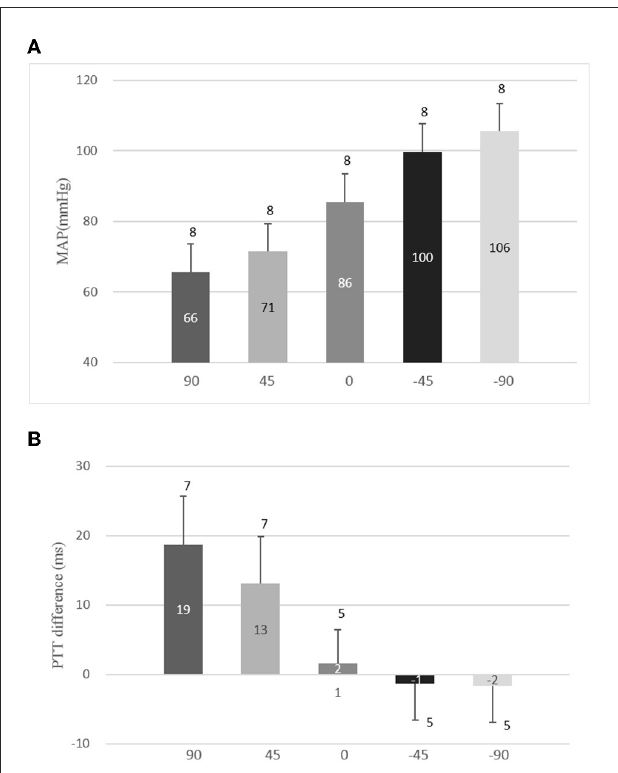
FIGURE2 Means and standard deviations (SDs) of mean arterial pressure (MAP) and pulse transit time (PTT) differences with the right arm at different positions. (A) Means and SDs of MBP with the right arm at five positions to the horizontal level and (B) means and SDs of PTT differences with the right arm at five positions to the horizontal